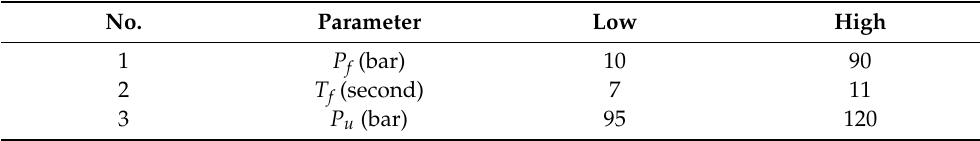
Table 6. Input parameters for each level in RFW of medium-carbon steel–304 SS.